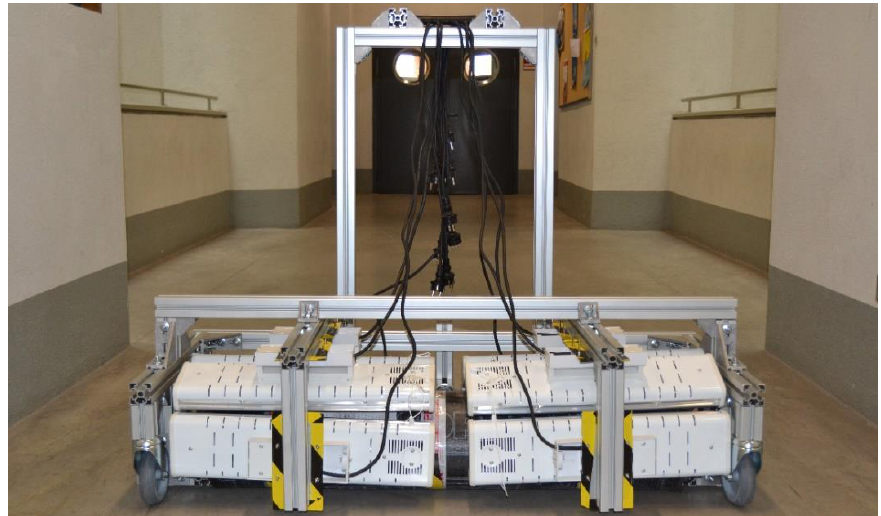
Figure 12. Prototype of the equipment for the fast installation of asphalt roofing based on infrared heaters.